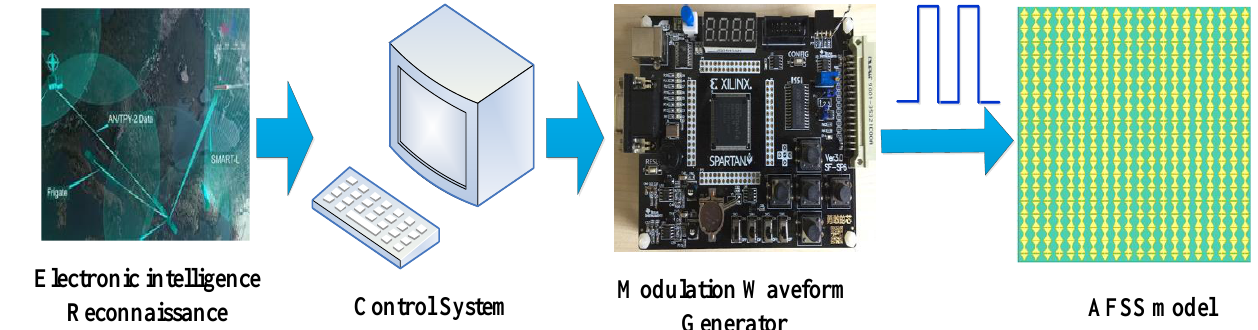
Figure 4. The procedure for generating modulation waveform.